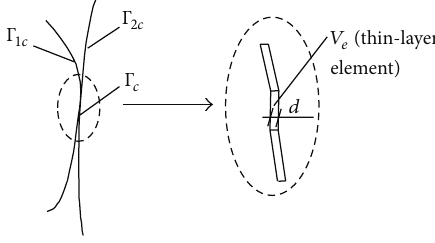
Figure 3: Thin-layer element method.